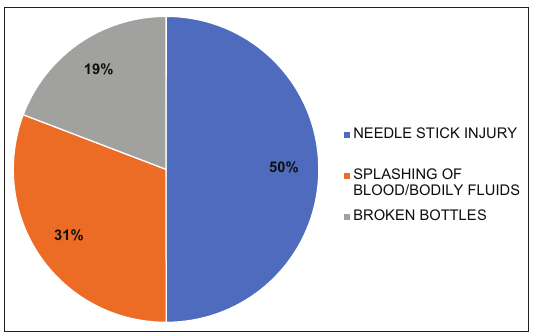
Figure 1 : Prevalence of Occupational Injury Types Among Study Participants